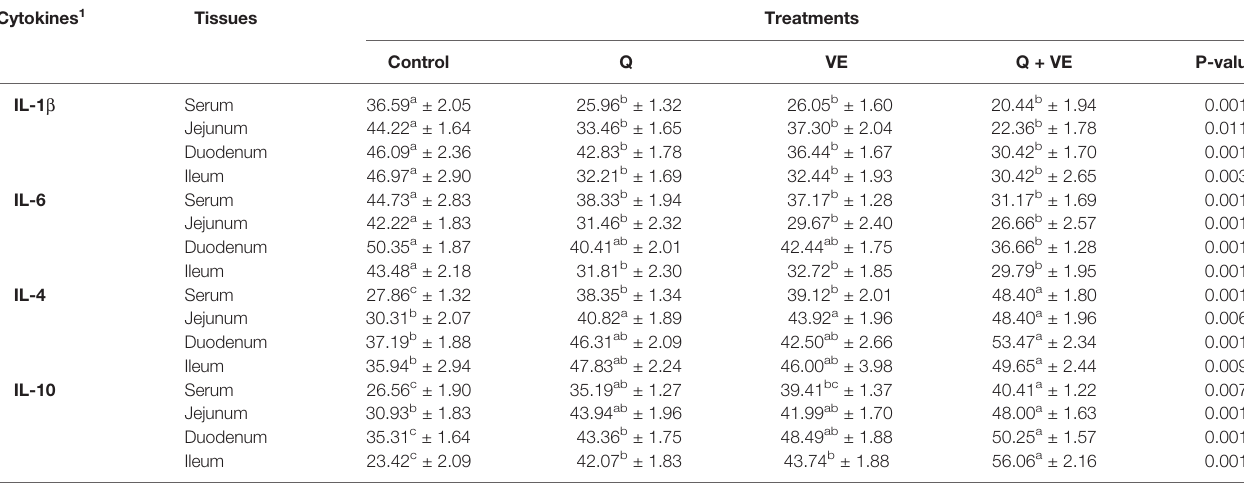
TABLE 3 | Effects of supplemental Q, VE, and Q + VE on pro- and anti-in fl ammatory cytokines in the intestinal mucosa and plasma of the aged breeder hens. Cytokines